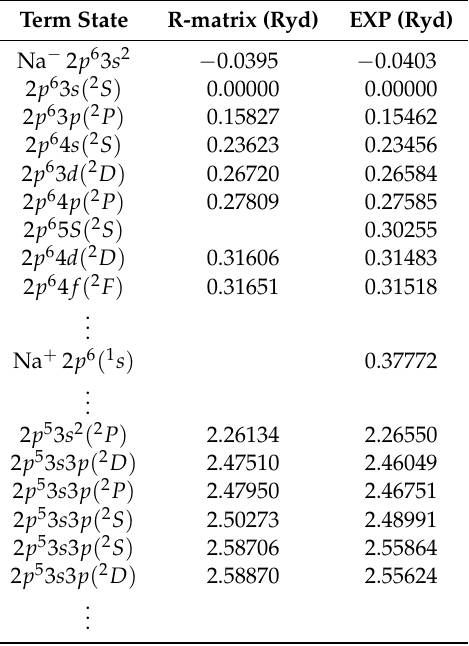
Table 1. R-matrix energies of the Na target states compared to the NIST values [27], the NIST Na + ground state energy, and the R-matrix electron affinity of Na − compared to experiment